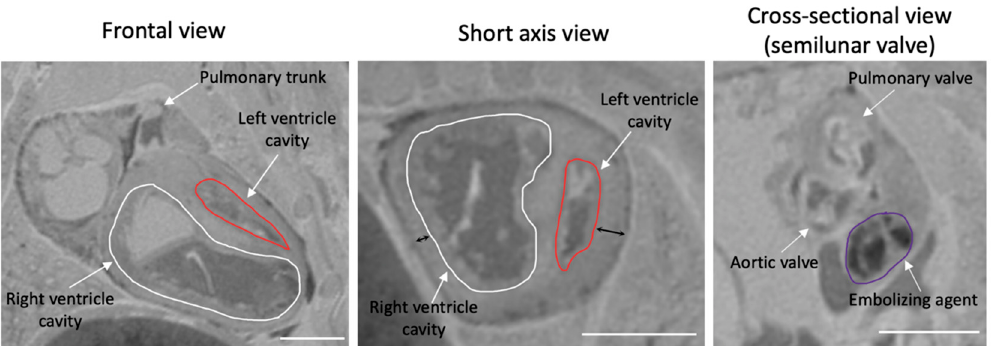
Figure 2. Slices from a three-dimensional magnetic resonance image of a gestational-term CD-1 mouse fetal heart. In the frontal view, a hypoplastic left ventricle cavity can be observed, and it is non-apex-forming. In the short-axis view (mid-ventricular level), myocardial wall thickness measurement was performed on the two-dimensional MR slice at the locations depicted by the double-headed black arrows. The left ventricle free-wall myocardium was thicker (0.27 mm) compared to the right ventricle free-wall myocardium (0.13 mm). In the cross-sectional view, the aortic valve annulus was comparable in size to the pulmonary valve. Scale bar: 1 mm.